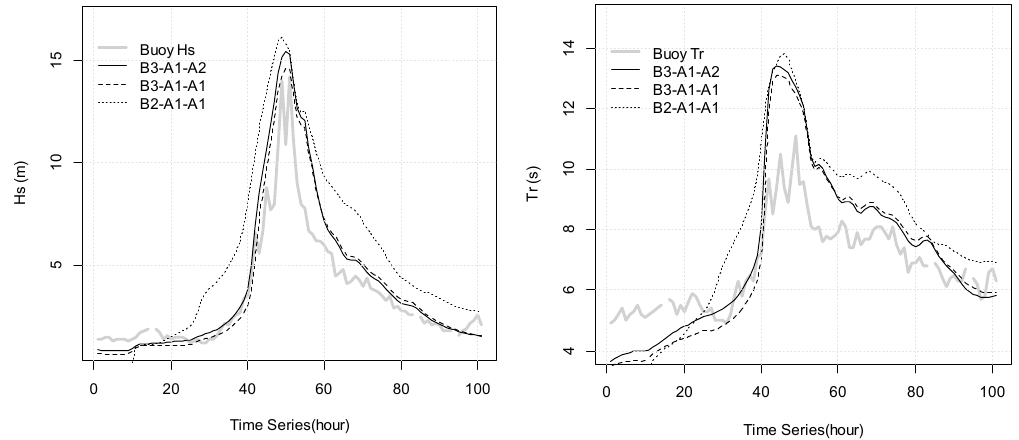
Figure A6. Comparison of typhoon waves induced by Typhoon Nepartak (01-2016) at buoy Taitung Open Ocean: the standard H10 is indexed as B2-A1-A1, the model with varying parameter b without an asymmetric typhoon structure is indexed as B3-A1-A1, and MH10 is indexed as B3-A1-A2.